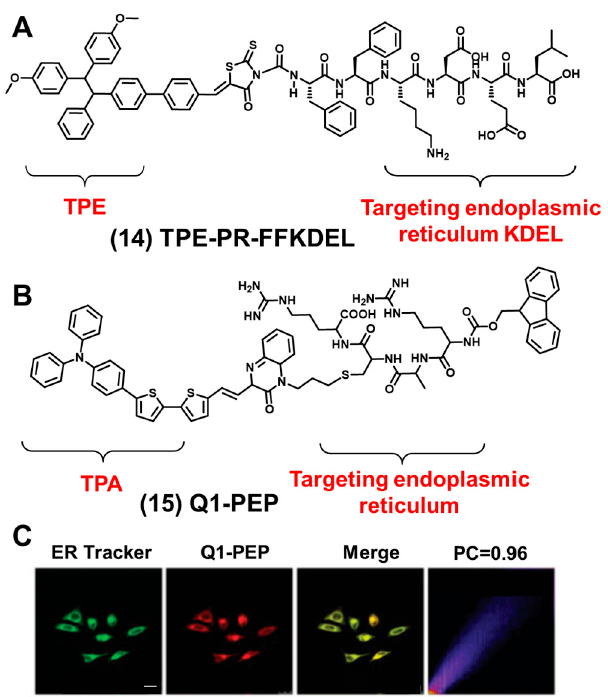
Figure 7. ( A ) Structural formula of TPE-PR-FFKDEL. ( B ) Structural formula of Q1-PEP. ( C ) Co-localization of Q1-PEP and the endoplasmic reticulum tracker (this figure was adapted from [87] with some modifications). The scale bar is 25 μ m.